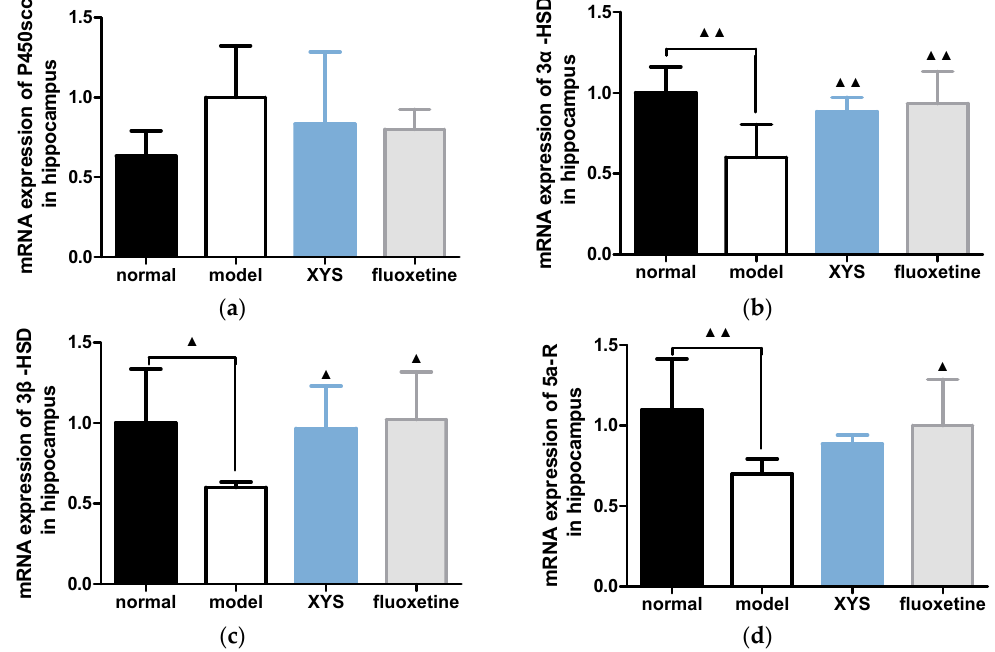
Figure 7. ( a ) mRNA expression of P450scc in hippocampus; ( b ) 3a-HSD; ( c ) 3 β -HSD; ( d ) 5a-R. The data were expressed as mean ± standard deviation ( x ± s), n = 10. ▲ p < 0.05, ▲▲ p < 0.01, compared with the model group.